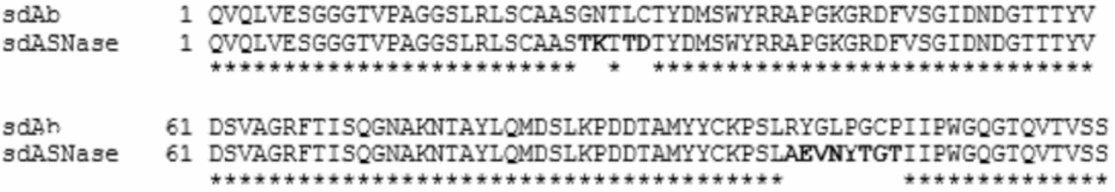
Figure 2. Amino acid sequence alignment of the original sdAb (from PDB ID: 1KXV, ( top )) and newly designed sdAS- Nase ( bottom ); in bold: transplanted amino acids; *: conserved amino